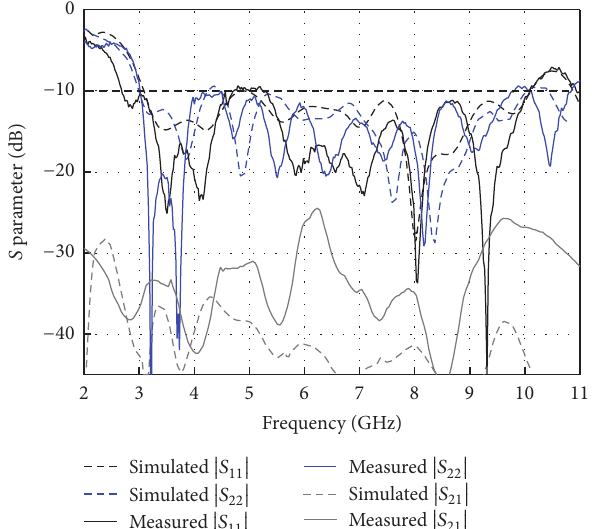
Figure 7: Simulated and measured results of 𝑆 -parameters for the dual-polarized UWB antenna.